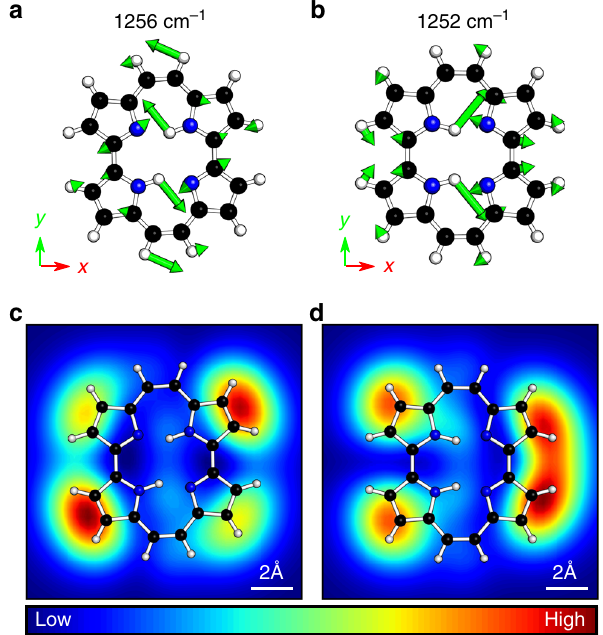
Fig. 5 Normal modes and TERS images of porphycene tautomers. Normal modes a at 1256 cm − 1 and b at 1252 cm − 1 make the dominant contributions to the TERS images at ~1250 cm − 1 of c trans and d cis tautomers adsorbed on a Cu(110) surface,